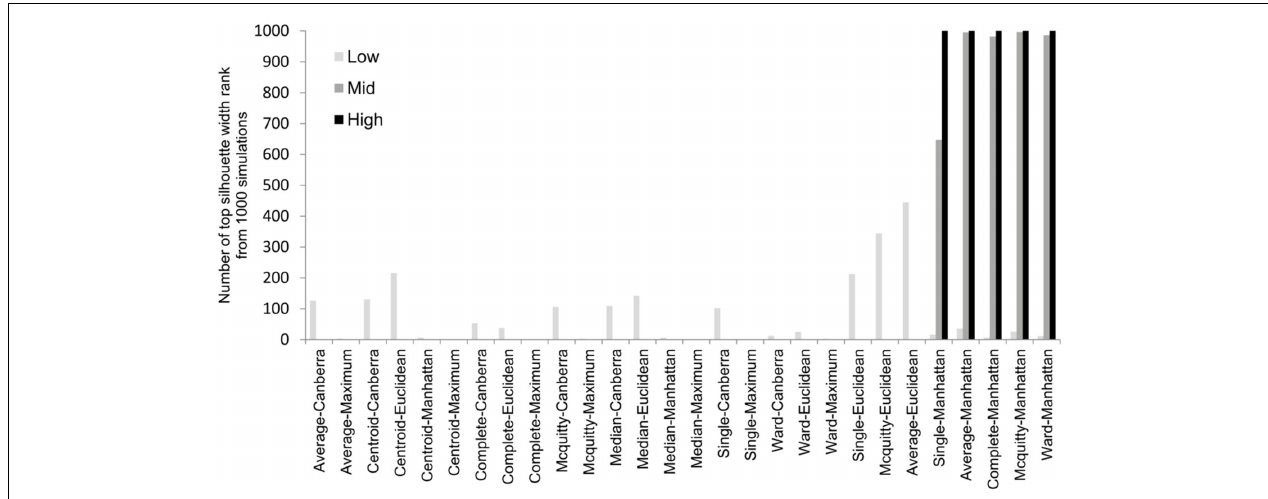
FIGURE 5 |The median number of highest silhouette rank obtained from 1000 simulations for each combination of distance measure and linkage method used. For clarity the data was combined into three groups, low (0.1 and 0.5% decisive data), mid (1% decisive data), and high (5 and 10% decisive